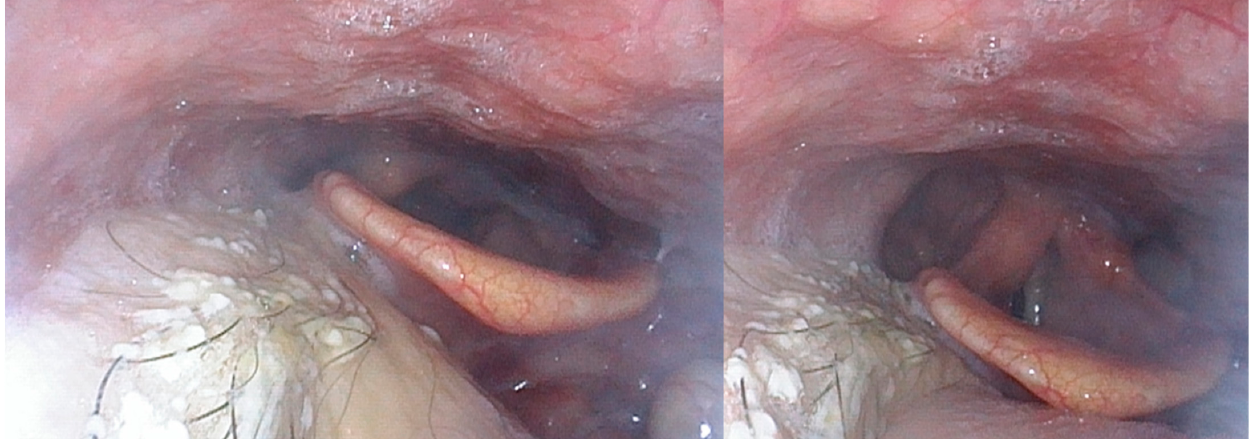
Figure 3. Nasofibroscopic views of a 60-year-old patient with a T3N0 hyalinizing clear-cell carcinoma of the tongue base. He underwent transoral robotic surgery and reconstruction with an anterolateral thigh free flap and did not require postoperative radiotherapy. Fourteen months after the surgery, he had a normal oral diet and speech and a very satisfactory quality of life.